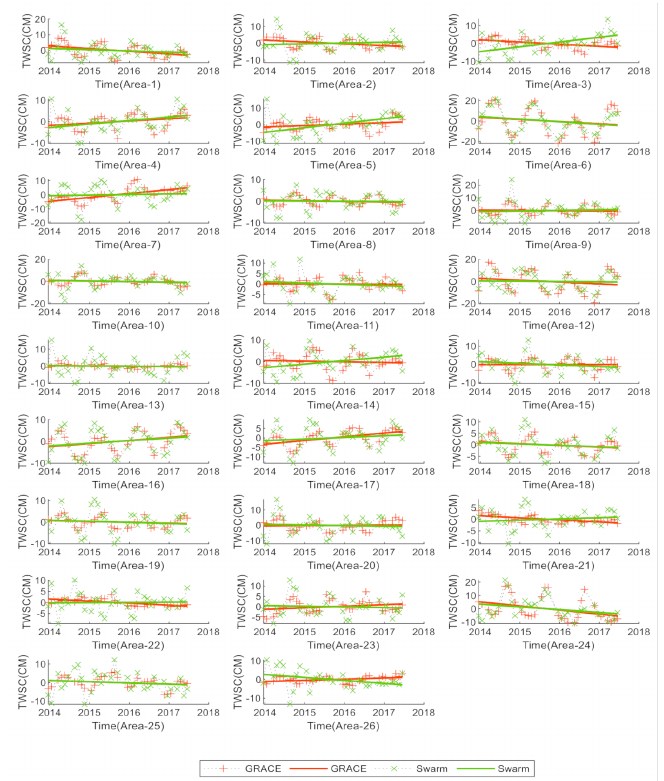
Figure 7. GRACE-TWSC and Swarm-TWSC time series and long-term (December 2013 to June 2017) trend plots for 26 areas. Table 14. Statistical table of water storage change information in 26